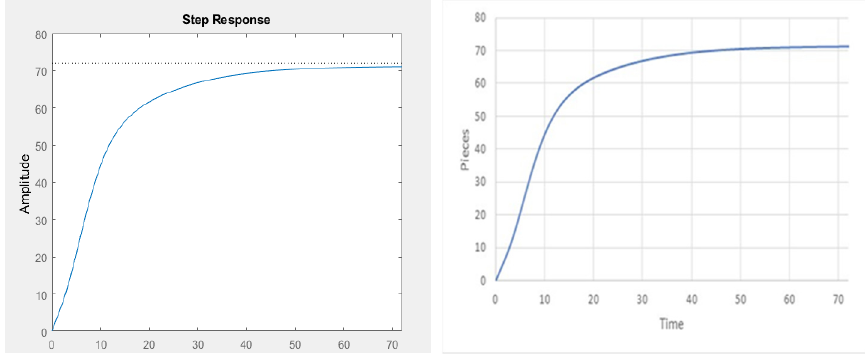
Figure 36. Output before a step input with an amplitude of 72, in Stella.